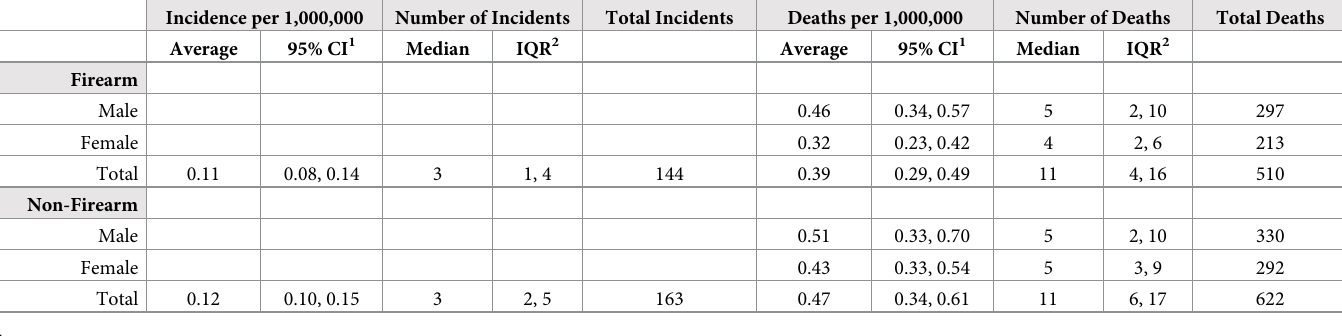
Table 1. Incidence and death rates of mass homicide by weapon type and sex. Incidence per